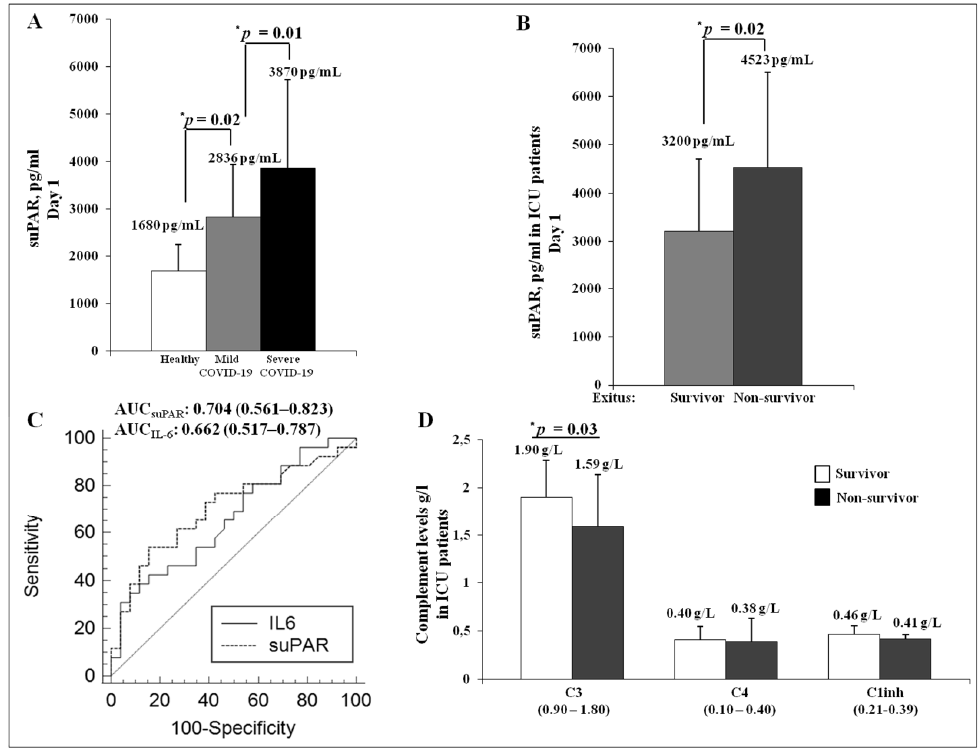
Figure 3. Analysis of serum suPAR levels in severe cases of COVID-19 during the Italian second wave. ( A ) serum suPAR levels in healthy controls (white column), mild cases (grey column) and severe cases of COVID-19 (black column); * p < 0.05. ( B ) analysis of serum suPAR levels in severe cases of COVID-19 hospitalized in the Intensive Care Unit (ICU) and classified in survivors (light grey column) and non-survivors (dark grey column). Asterisk indicates statistical significance between survivors and non-survivors, determined by the Student t -test (* p < 0.05). ( C ) Receiver Operating Curve (ROC) analysis of IL-6 and suPAR to define unfavorable outcome in the ICU cohort. Areas under the curve (AUCs) and 95% confidence intervals are shown. ( D ) analysis of the complement system in the ICU cohort patients classified in survivors (white column) and non-survivors (black column). C3, C4 and C1 inhibitor (C1inh) measurement was performed through nephelometric technique. Asterisk indicates statistical significance between survivors and non-survivors, determined by the Student t -test (* p < 0.05).